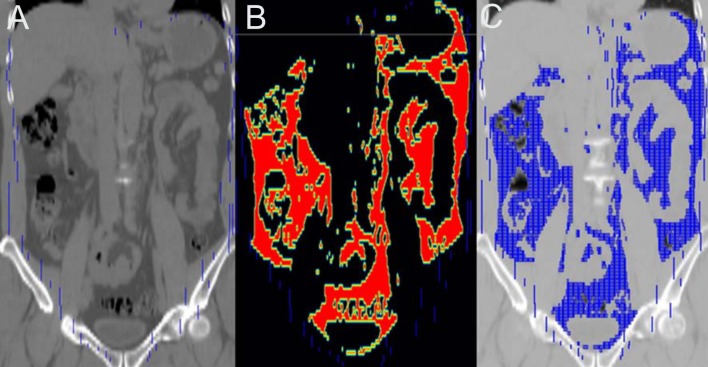
Measurement of whole visceral adipose tissue.(A) Manually outlining volume-of-interest of the abdominal muscular wall, (B) defining voxels between -195HU and -45HU, making a template atlas, and (C) applying a template atlas to CT.